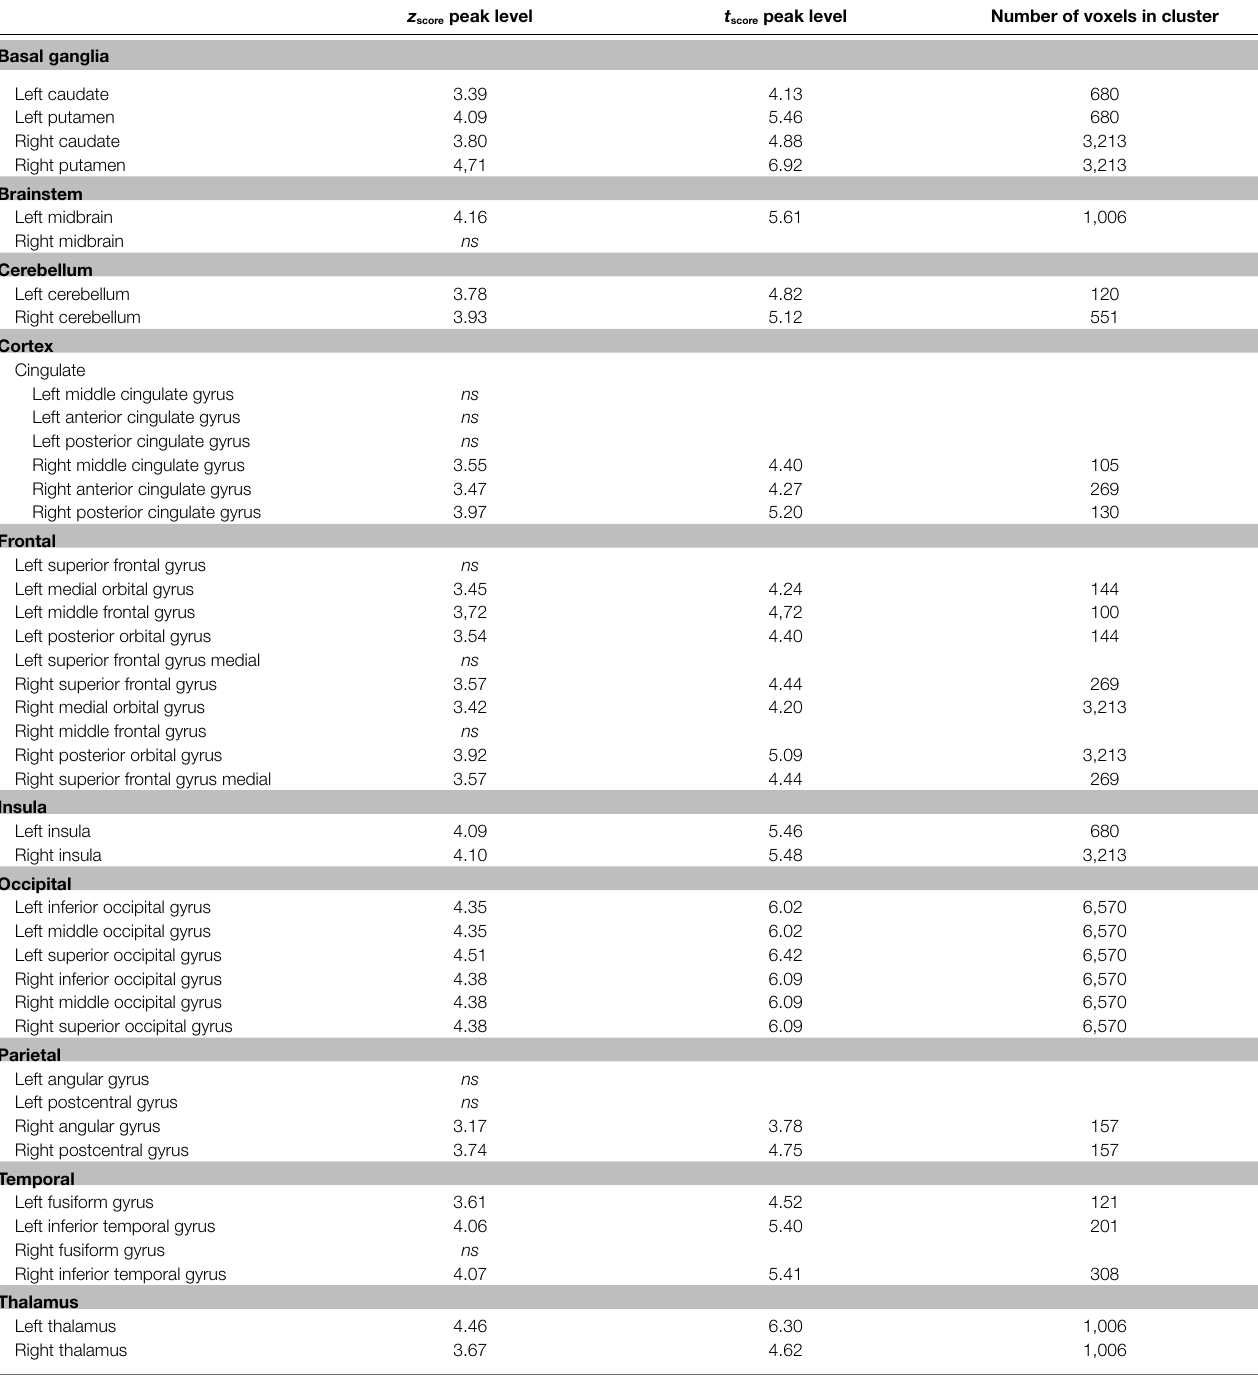
TABLE 2 | Negative change in regional cerebral perfusion after DI. z score peak level t score peak level Number of voxels in